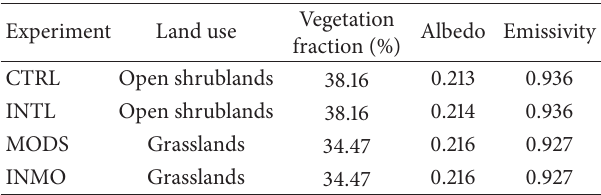
Table 4: Land surface information and parameters at